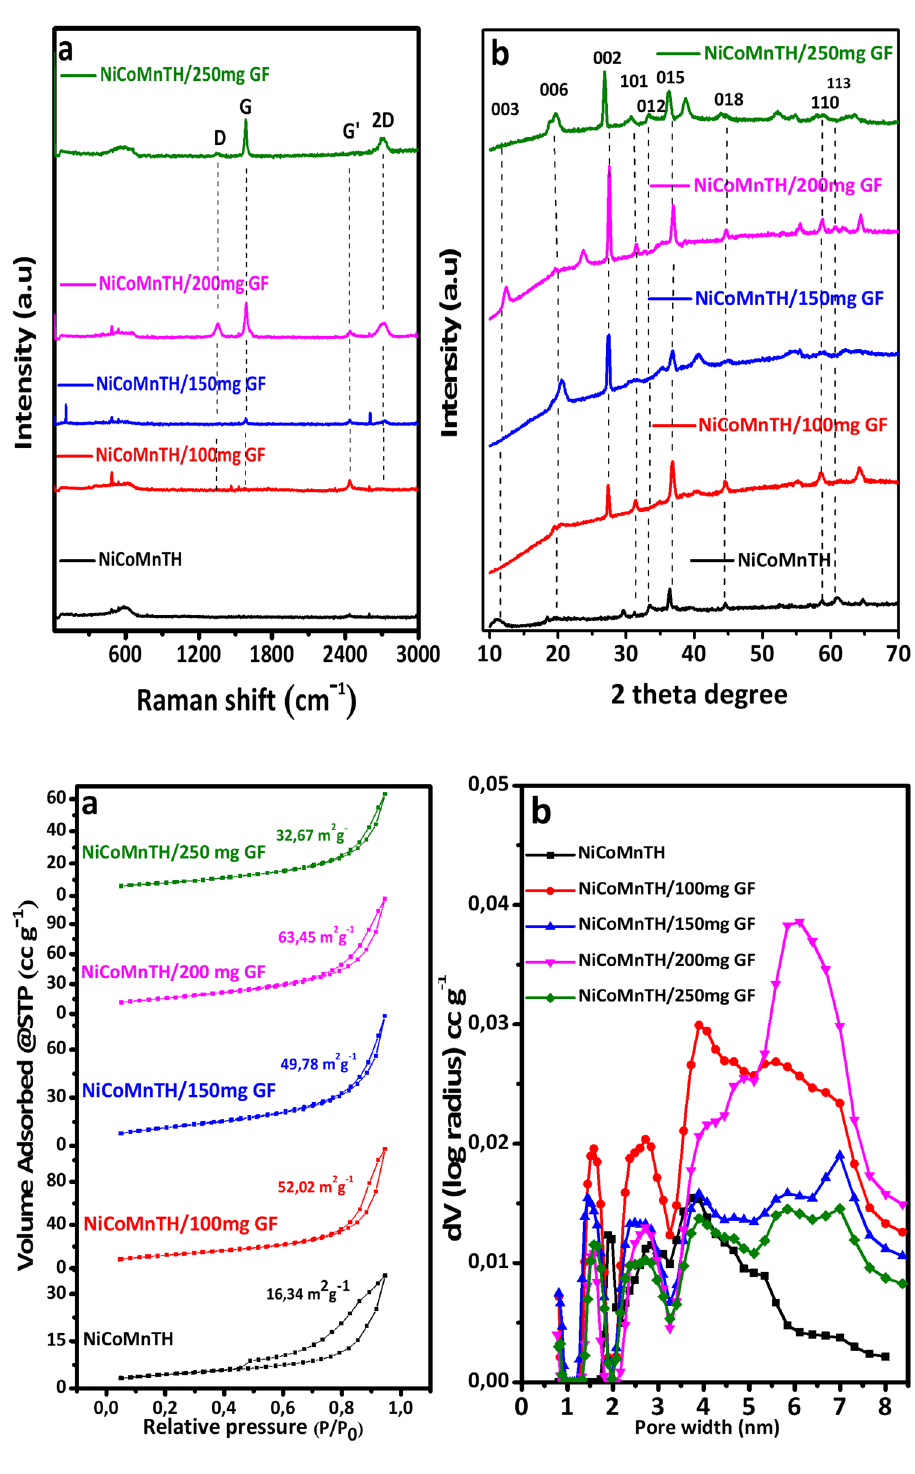
Fig. 6 a Raman spectra, and b XRD patterns of as-synthesised samples, respectively